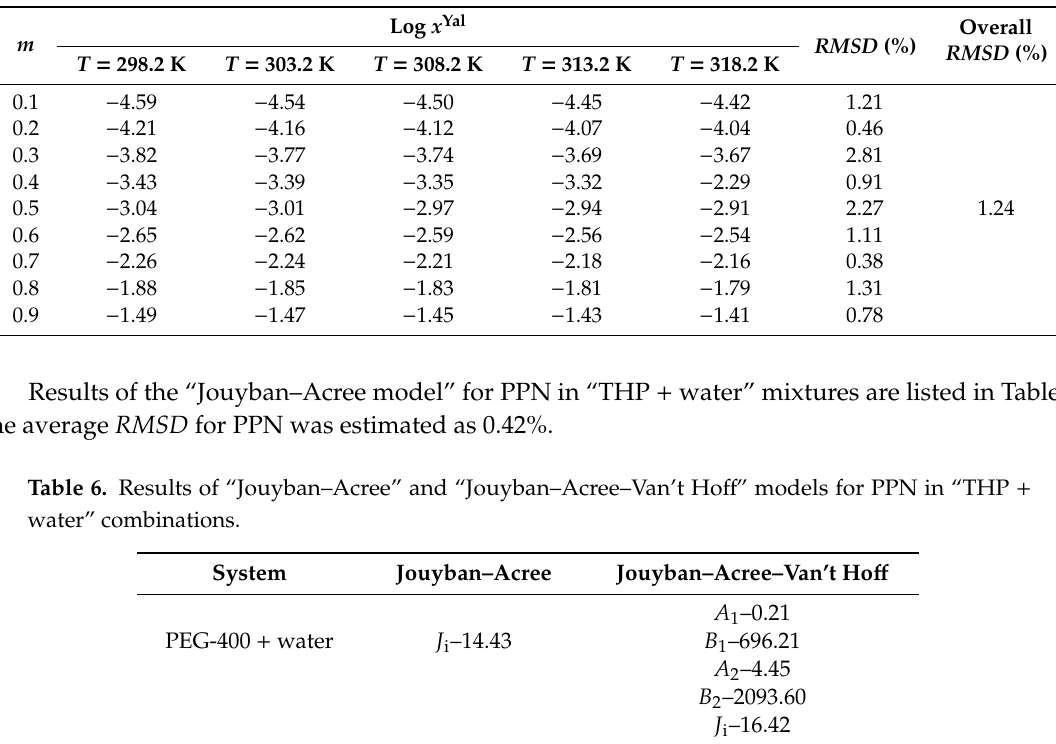
Table 5. Results of “Yalkowsky–Roseman model” for PPN in di ff erent “THP + water” mixtures ( m ) at “ T = 298.2–318.2 K”.